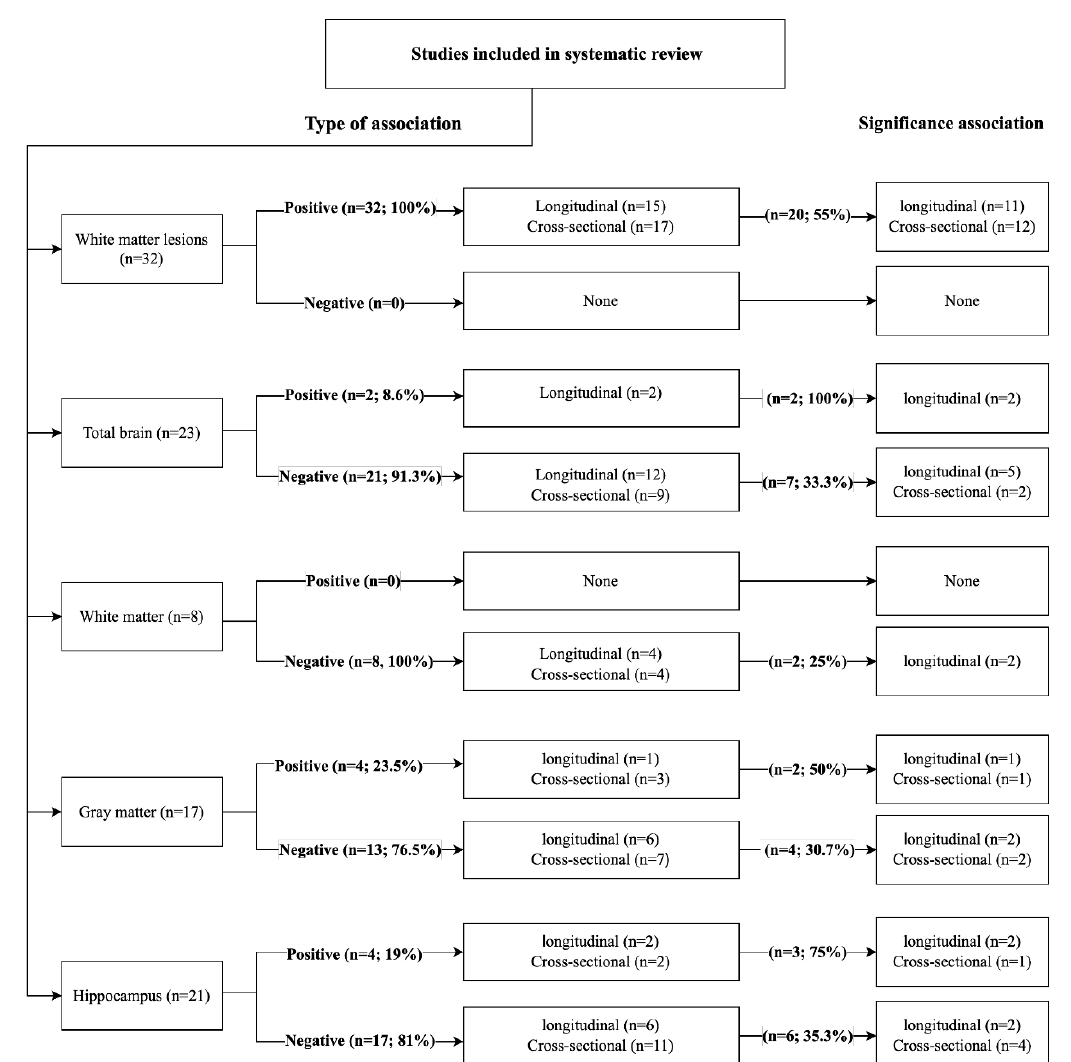
Figure 4. Flow diagram detailing the number of all included studies ( n = 52) which reported positive or negative associations between BP and different brain regions.